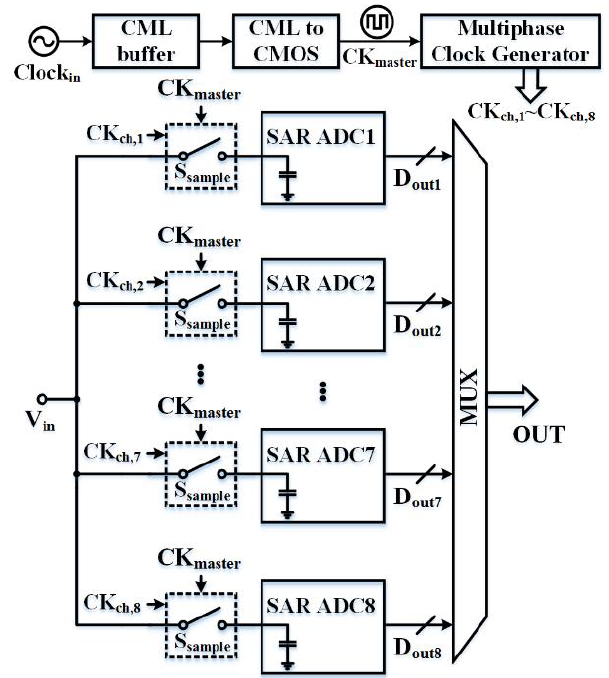
Figure 1. Eight-channel time-interleaved (TI) successive approximation register (SAR) analog-to-digital converter (ADC) architecture.